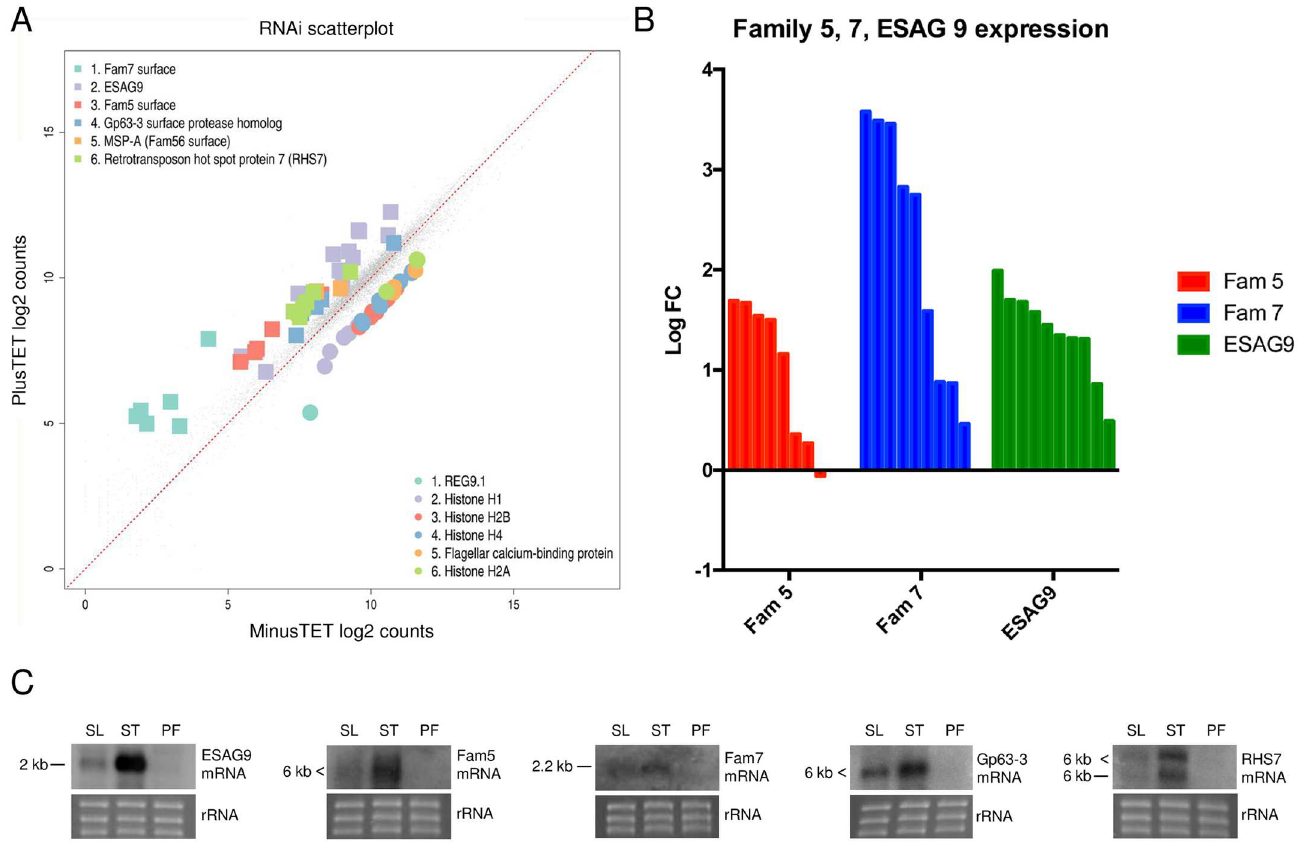
Fig 5. Global transcriptome changes associatedwith REG9 . 1 RNAi. A. Transcripts up and down regulatedupon REG9 . 1 RNAi in pleomorphic trypanosomes. The data represents an analysisof biological replicates whethercells were inducedor not to deplete REG9 . 1 (two replicateseach). The down regulationof histonesand the upregulation of key regulatedmolecules,including ESAG9 (lilac), Family 5 (red) and Family 7 members (blue) is highlighted.B. RelativeLogFC (Log2 fold change)expressionof different members of T . brucei surface protein Family 5 (red) Family 7 (blue) and ESAG9 (green)after REG9 . 1 depletionby RNAi. C. Northernblots of ESAG9 , Family 5 and family 7 transcripts in slender (SL), stumpy (ST) and procyclic forms (PF). The similarity within family 5 and 7 results in the detectionof multiplefamily members by the riboprobes, generatinga smear of bands. Northerns for GP63 and RHS7 are also shown, both being upregulatedin the RNA-seq dataset. rRNA provides the loadingcontrol.